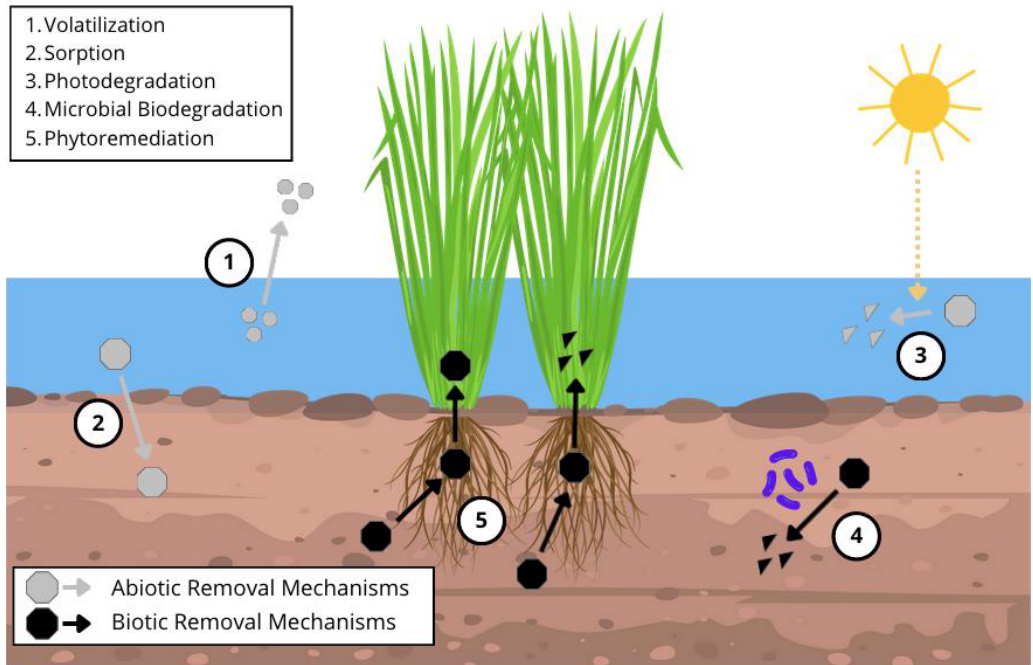
Figure 1. Wetland removal mechanisms of emerging contaminants. Octagons represent parent compounds, triangles represent transformation products. Abiotic removal mechanisms in grey, biotic removal mechanisms in black. Purple rods represent bacteria involved in biodegradation.